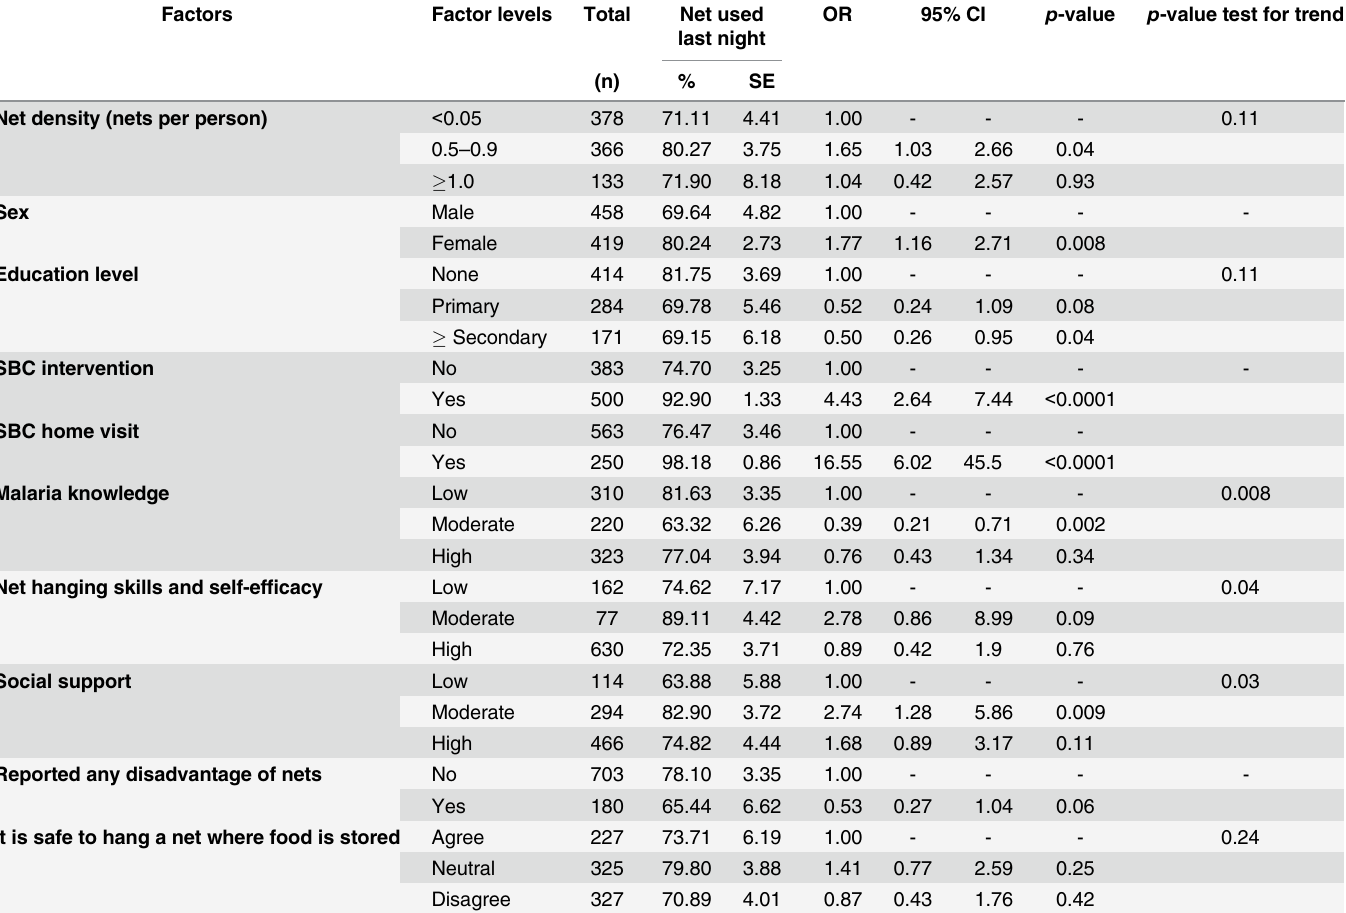
Table 3. Univariable logistic regression analysis between individual net use and explanatory factors among survey respondents living in house- holds owning at least one net, Ebonyi state, Nigeria. CI: confidence interval; SE: standard error; Net density: number of nets per household member; SBC: social behavior change intervention. Factors